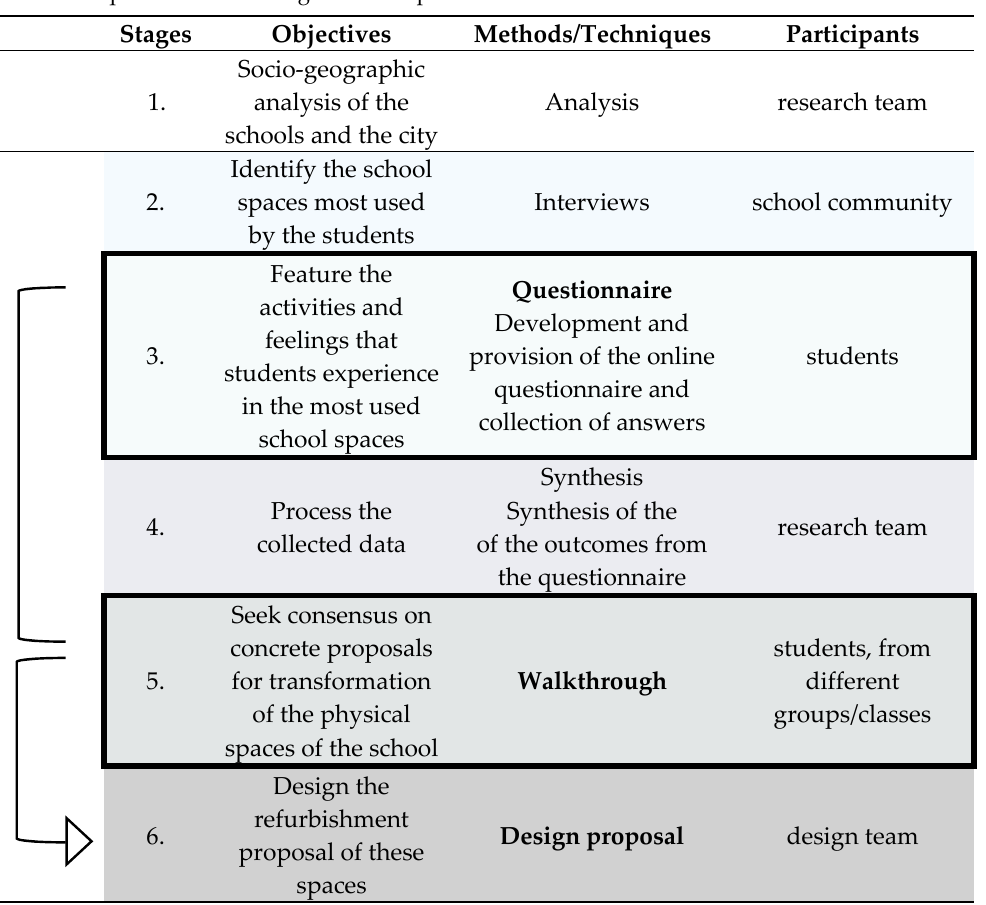
Table 1. Sequential methodological development of the S3S tool.